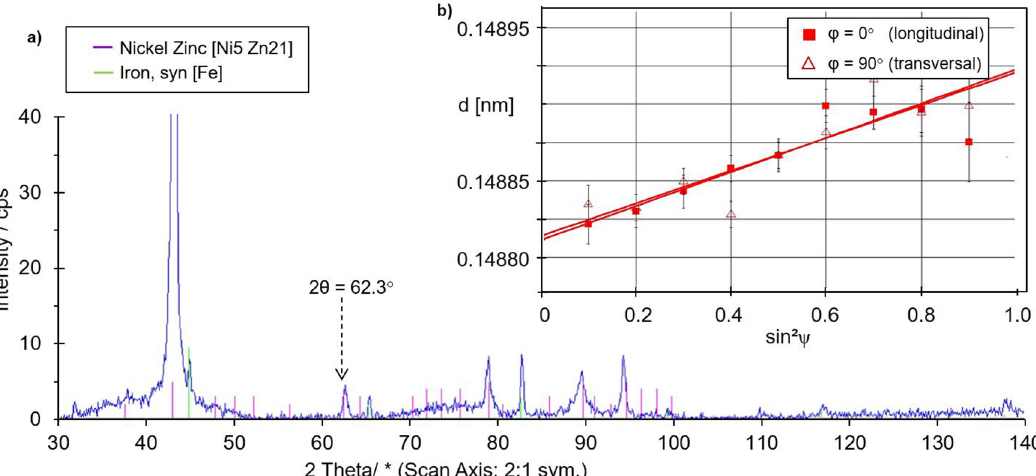
Fig. 5. (a) Diffractogram of the ZnNi layer with interference positions of Fe and Ni5Zn21, (b) residual stress analysis of the ZnNi layer in s 11 and s 22 direction at 2 u = 62.3 °